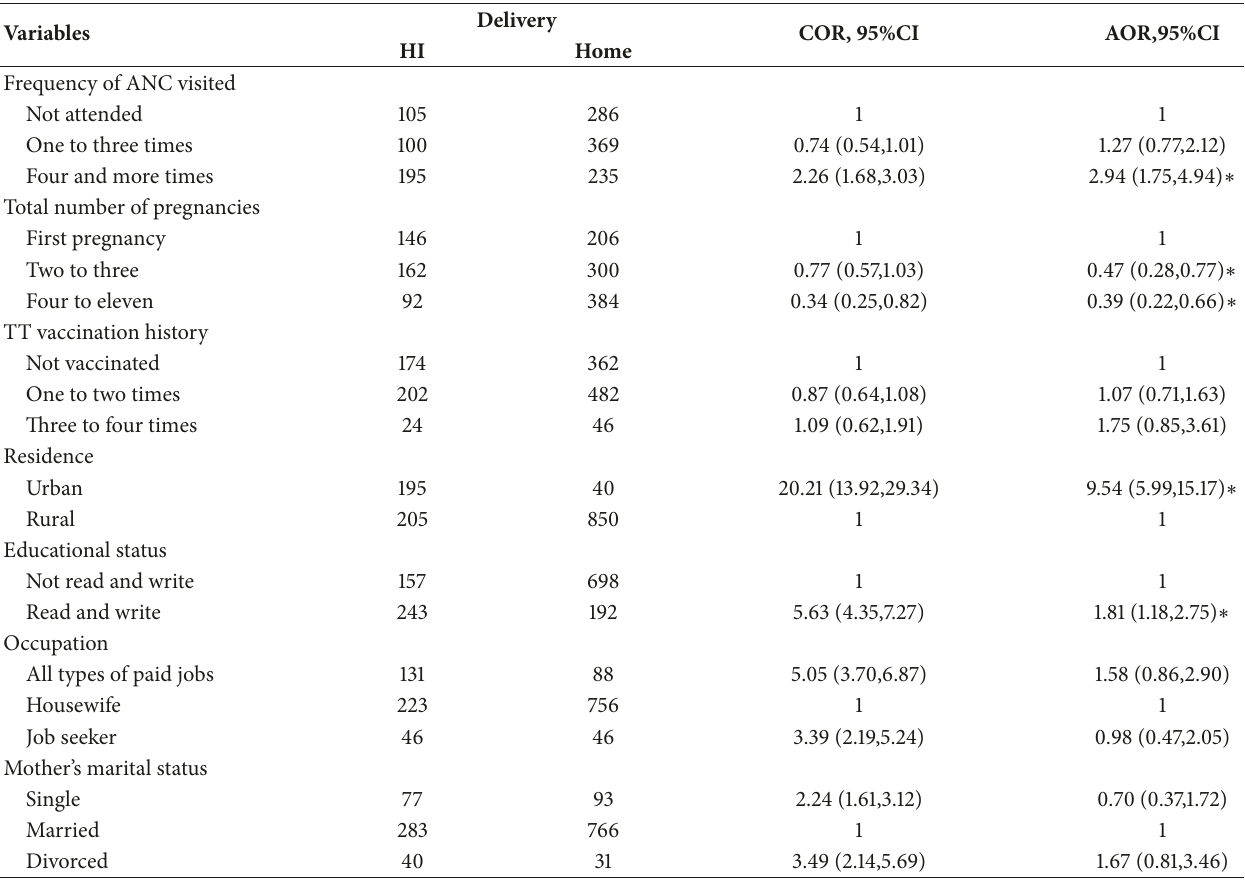
Table 3: Bivariable and multivariable logistic regression analysis of factors associated with skilled institutional delivery at DHDSS site, northwest Ethiopia,